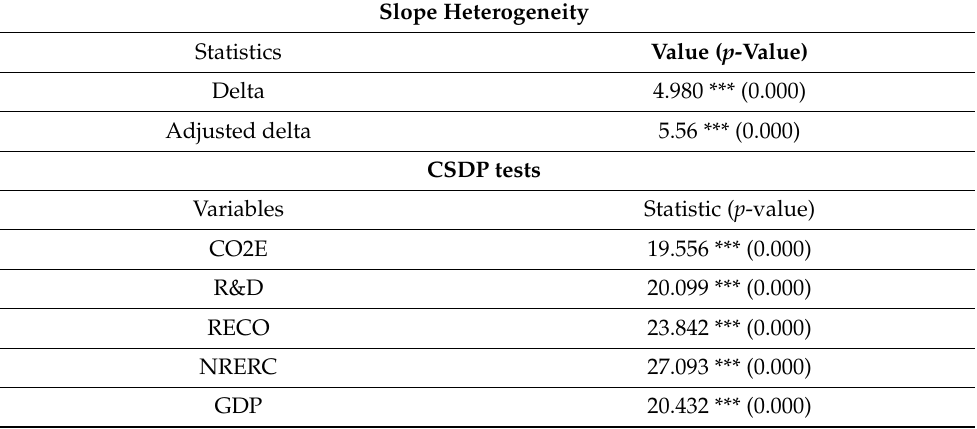
Table 3. Slope heterogeneity and CSDP